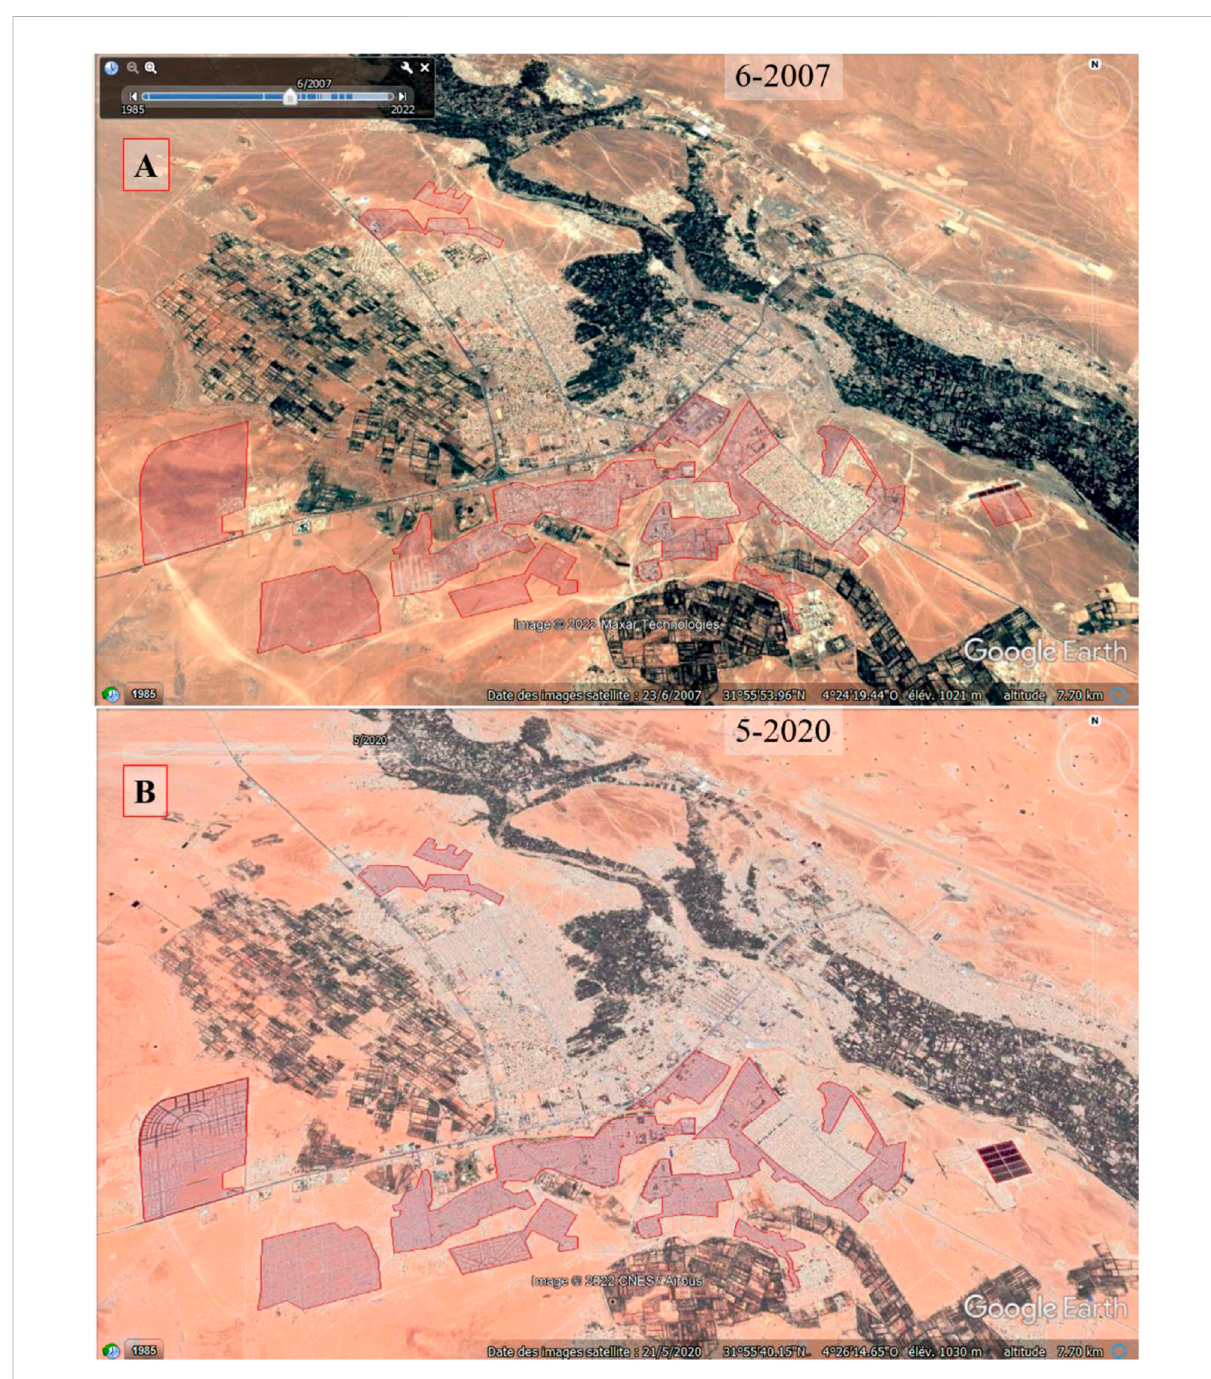
FIGURE 7 Change of the buildup area of Errachidia city in two years using Google Earth images. (A) in 2007; and (B) in